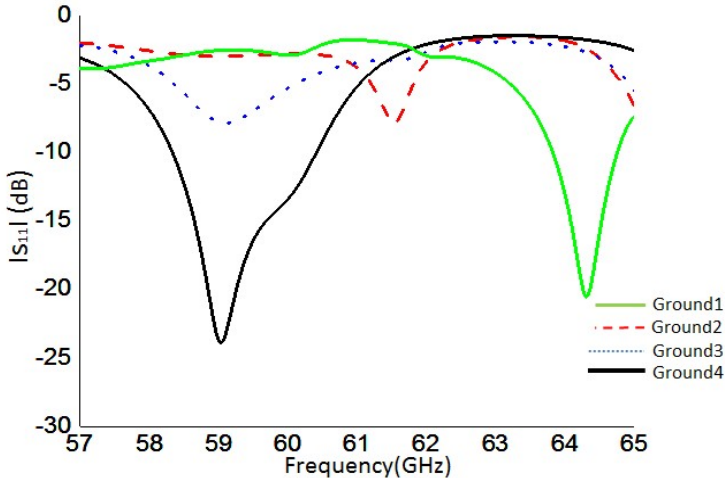
Figure 4. Simulated return loss characteristics of varied ground structures. Table 2. Simulation results of the ground plane iteration.